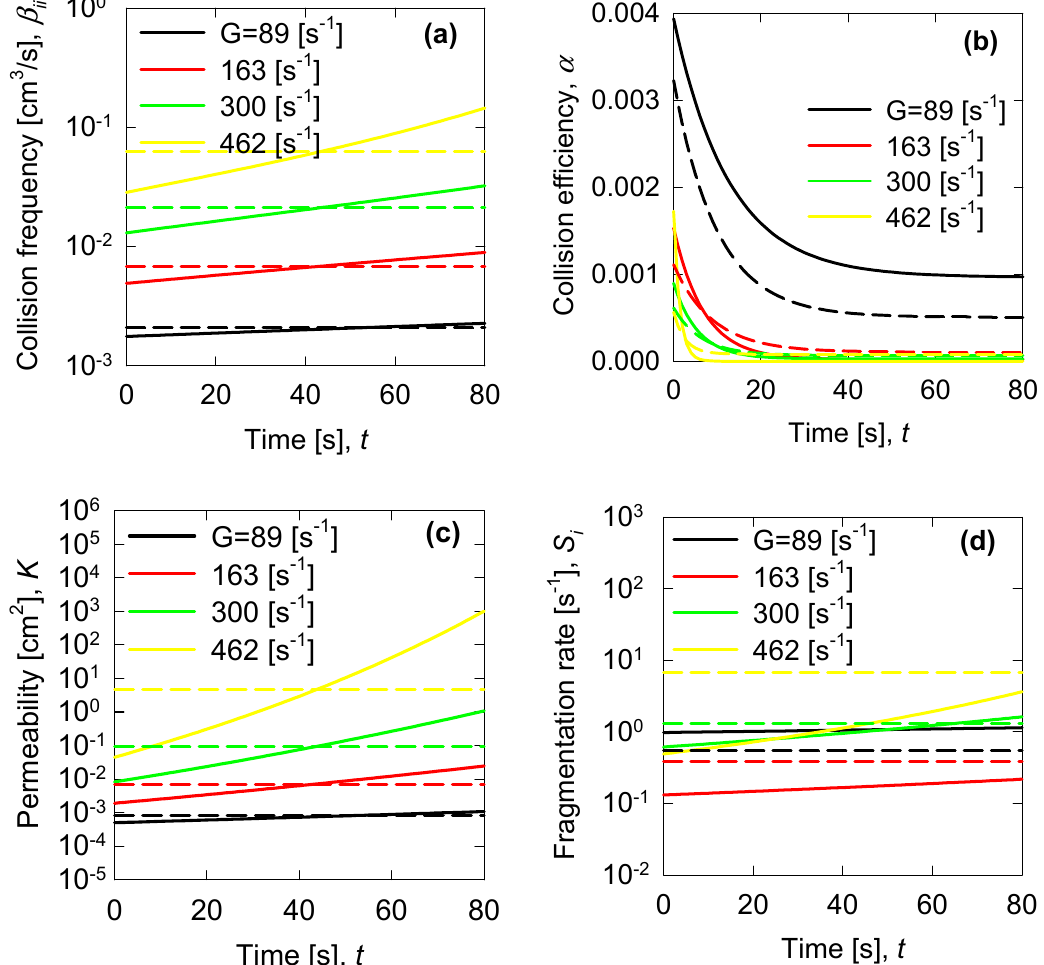
Figure 4. PBM representation of collision frequency ( a ), collision e ffi ciency ( b ), aggregate permeability ( c ) and fragmentation rate ( d ) for the largest aggregates considering constant fractal dimension of the aggregates (dashed lines) and time-dependent fractal dimension (solid lines) for di ff erent mixing intensities. Aggregate size range is 200–600 µ m (bin i =